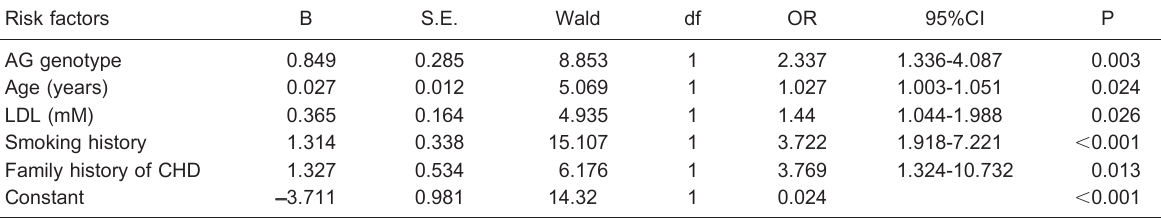
Table 4. Results of logistic regression analysis for screening risk factors of coronary artery heart disease (CHD) and predicting occurrences of CHD. Risk factors